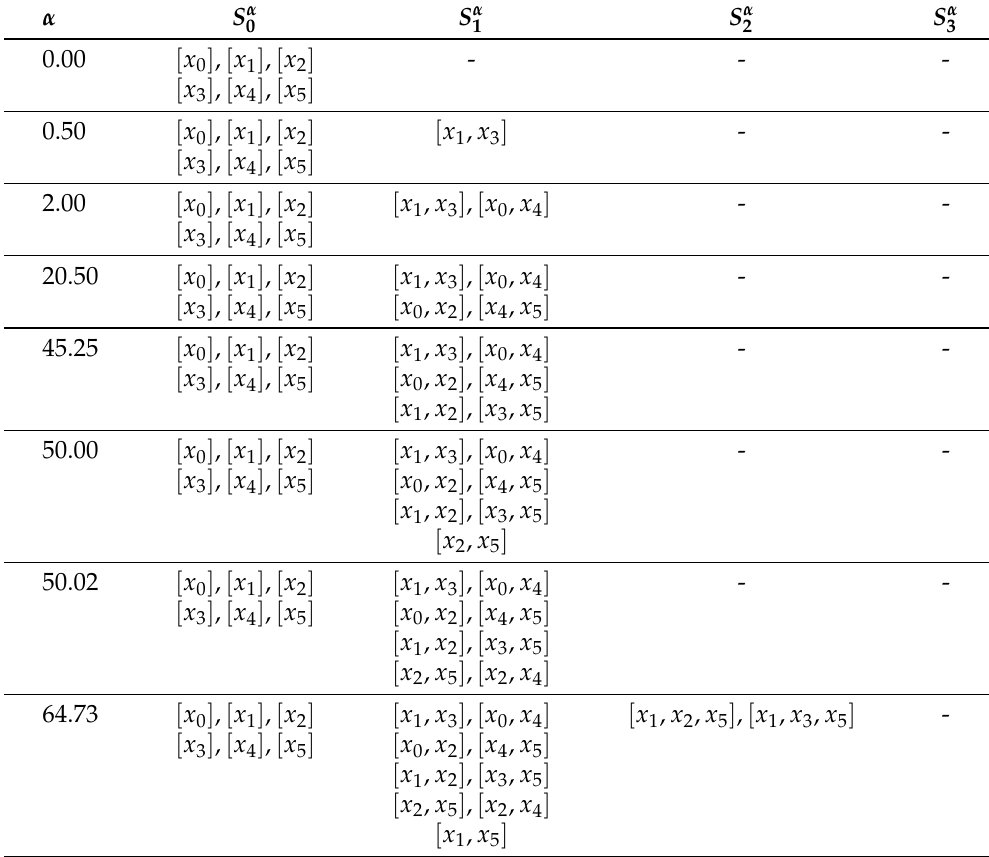
Figure 3. Example of data points M . The filtration values are computed and presented below in Table 1: Table 1. Alpha Filtration of M